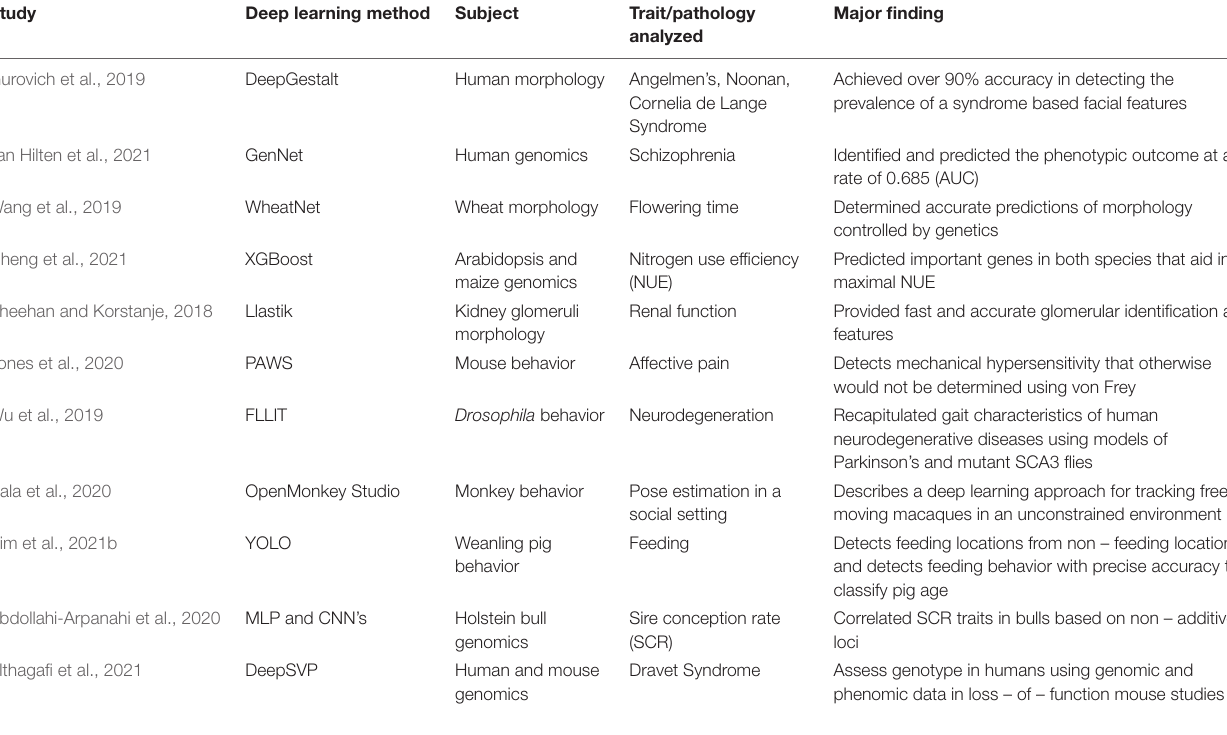
TABLE 5 | A selection of studies using deep learning to integrate genomic sequencing and behavioral